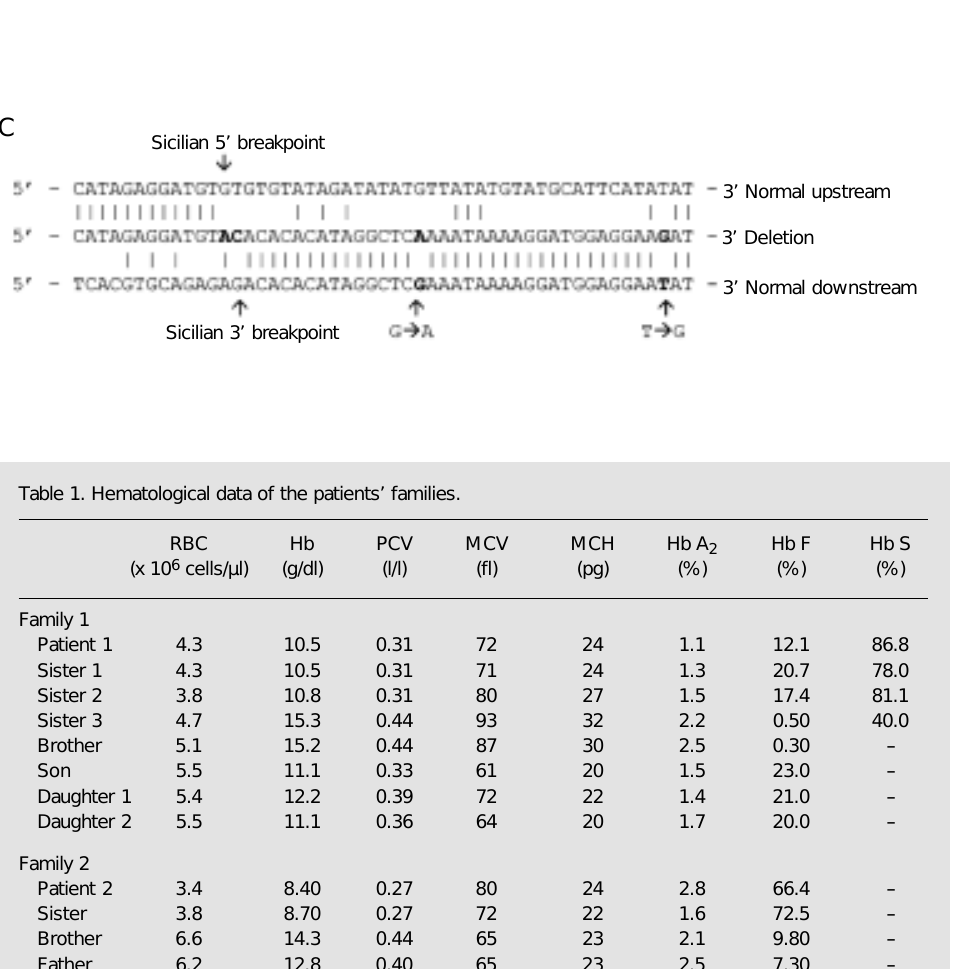
Figure 1. Analysis of the Sicilian ( δ ß) º -thalassemia deletion. A , Representation of the human ß- globin gene cluster and location of the Sicilian 13,379-bp dele- tion (black bar). The distribution of the three oligonucleotides used is also included (arrows). B , Ethidium bromide-stained agarose gel (1.2%) with the PCR products for the deletions. The upper band (1,585 bp) is the nor- mal allele and the lower band (1,150 bp) the mutant allele. Lane 1 , DNA marker φ X174/ Hae III; lane 2 , control; lane 3 , patient 1; lane 4 , patient 2; lane 5 , DNA marker φ X174/ Hae III. C , Mutant fragment sequence compared to the normal up- stream and downstream se- quences. Vertical lines connect identical bases. The arrows indi- cate the Sicilian breakpoints and the base substitutions. The two orphan nucleotides are